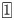
Challenges associated with plasma cell segmentation; numbers in boxes indicate the following image regions: 1 nucleus of plasma cells, 2 cytoplasm of plasma cells, 3 unstained cells, and 4 background.Three challenges are highlighted via this Fig: 1) At times, the color difference between the cytoplasm with the adjacent background is less; 2) Plasma cells may be clustered together and hence, segmentation of the overlapping/touching cells is required; and 3) there may be more than one type of stained and unstained cells posing difficulty in extracting plasma cells of interest.